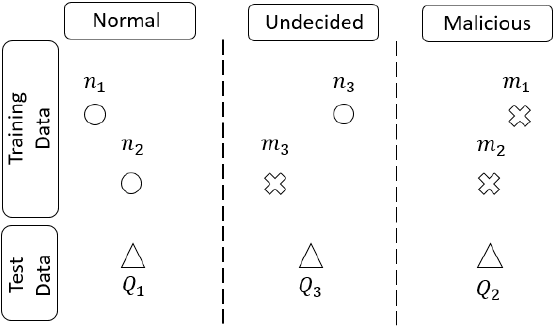
Figure 5. kNN classification for fast malware detection.